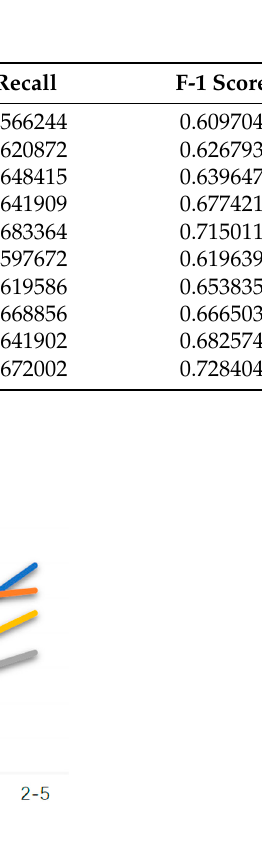
Figure 10. Evaluation indicators of different experiments.